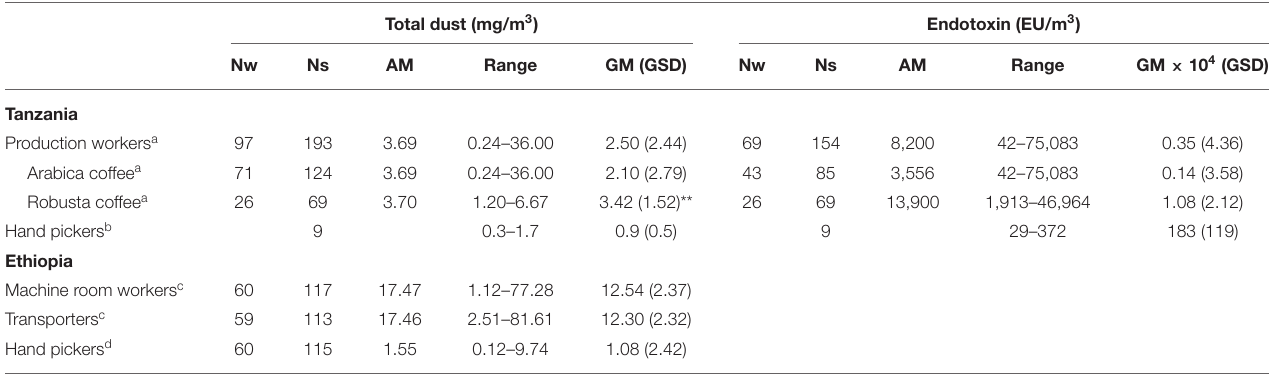
TABLE 1 | Personal full-shift exposure to total dust and endotoxin among coffee production workers in Tanzania and Ethiopia. Total dust (mg/m 3